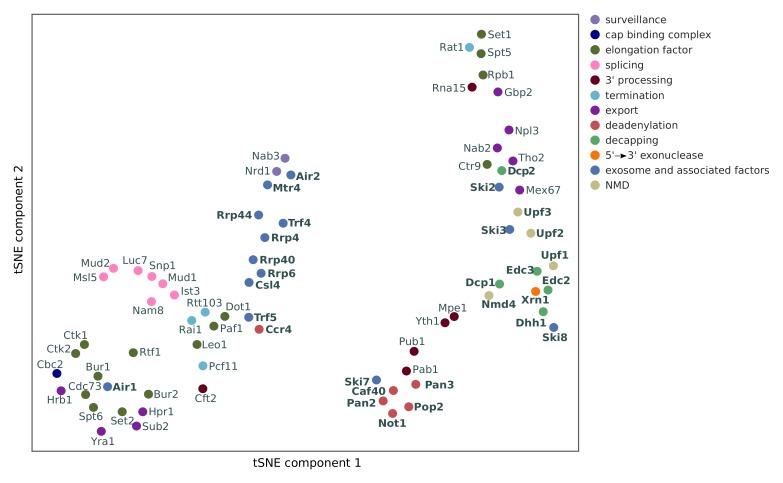
Two-dimensional embedding of co-localization between 74 RNA processing factors.tSNE plot visualizes similarities in co-localization profiles between RNA processing factors (factors are color-coded based on their function). Analysis for 74 RNA processing factors, including 30 factors from this study (marked in bold), and 44 factors from previous studies (Baejen et al., 2017; Baejen et al., 2014; Battaglia et al., 2017; Schulz et al., 2013) (see Supplementary file 1).